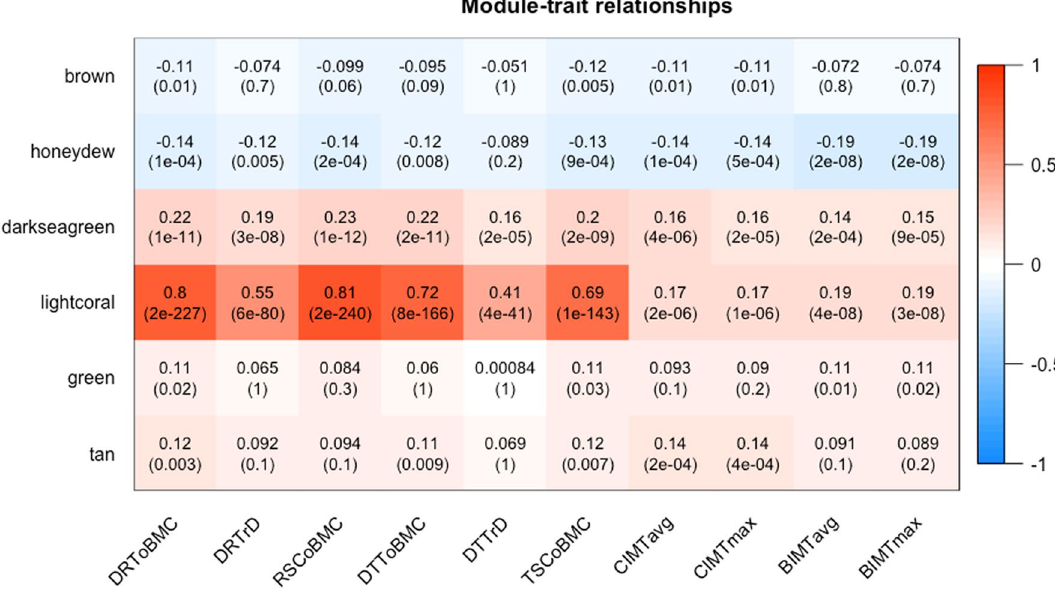
Figure 2. Relationships between gene co-expression modules (x-axis) and early traits (y-axis). The rows correspond to the different gene modules (named by colour) and their summary expression profile; for example, brown represents the summary expression profile for the module brown . The columns correspond to the measured early traits of osteoporosis (pQCT traits) and atherosclerosis (ultrasound traits) used in the biostatistical analyses. The values in the cells represent Pearson’s correlation coefficients (r), with the associated Bonferroni-adjusted p-values in parentheses below the coefficient. The modules are named by colour, and the correlation coefficients have a colour-coding shown in the colour scale (between − 1 and + 1) on the right side of the figure. Acronyms: DRToBMC , distal radius total bone mineral content; DRTrD , distal radius trabecular bone mineral density; RSCoBMC , radial shaft cortical bone mineral content; DTToBMC , distal tibia total bone mineral content; DTTrD , distal tibia trabecular bone mineral density; TSCoBMC , tibia shaft cortical bone mineral content; CIMTavg , average carotid intima-media thickness; CIMTmax , maximum carotid intima- media thickness; BIMTavg , average bulbus intima-media thickness; BIMTmax , maximum bulbus intima-media